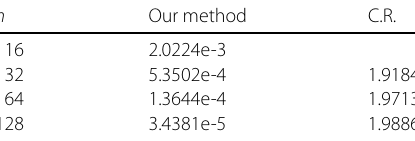
Table 5 E ( h ) of Example 3